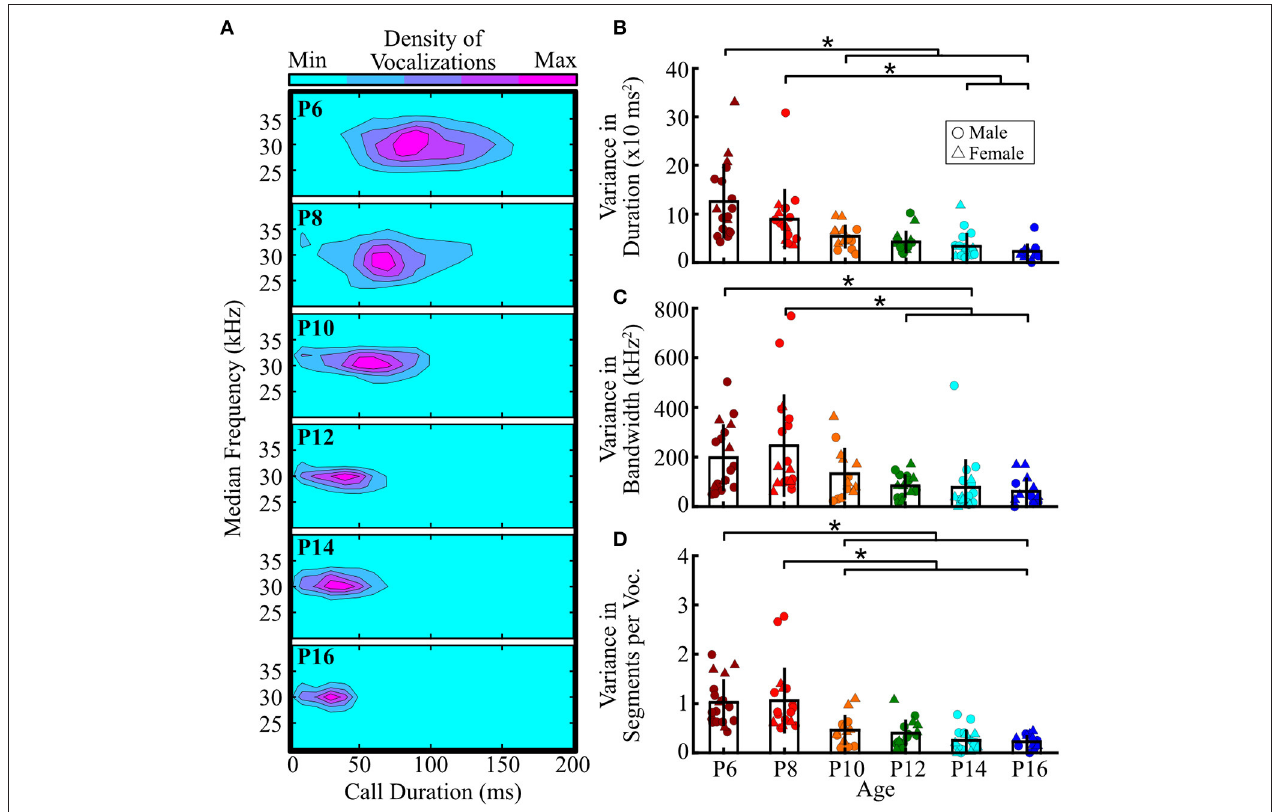
FIGURE 6 | Pup isolation vocalizations become more stereotyped with age. (A) Distributions of median frequency and duration of pup vocalizations across ages. Warmer colors indicate greater numbers of vocalizations falling within the region. (B–D) Within-animal variability across ages for (B) vocal duration, (C) bandwidth (high minus low frequency of the fundamental contour), and (D) number of segments per vocalization. Each dot represents the variability for a single pup, measured by finding the variance of that feature (sum of squares/n-1) across all calls emitted by that pup, with higher values indicating more variability. There was no main effect of sex for any comparison, so male and female data were collapsed. Bars represent group means, and vertical lines represent standard deviations. Males are represented by circles, females by triangles. * p < 0.05 (ANOVA with Tukey’s HSD post-hoc